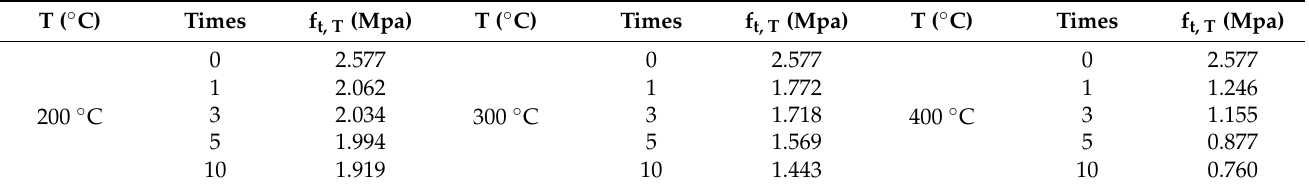
Table 4. Splitting tensile strength of magnetite concrete exposed to multiple heating at high temperature.